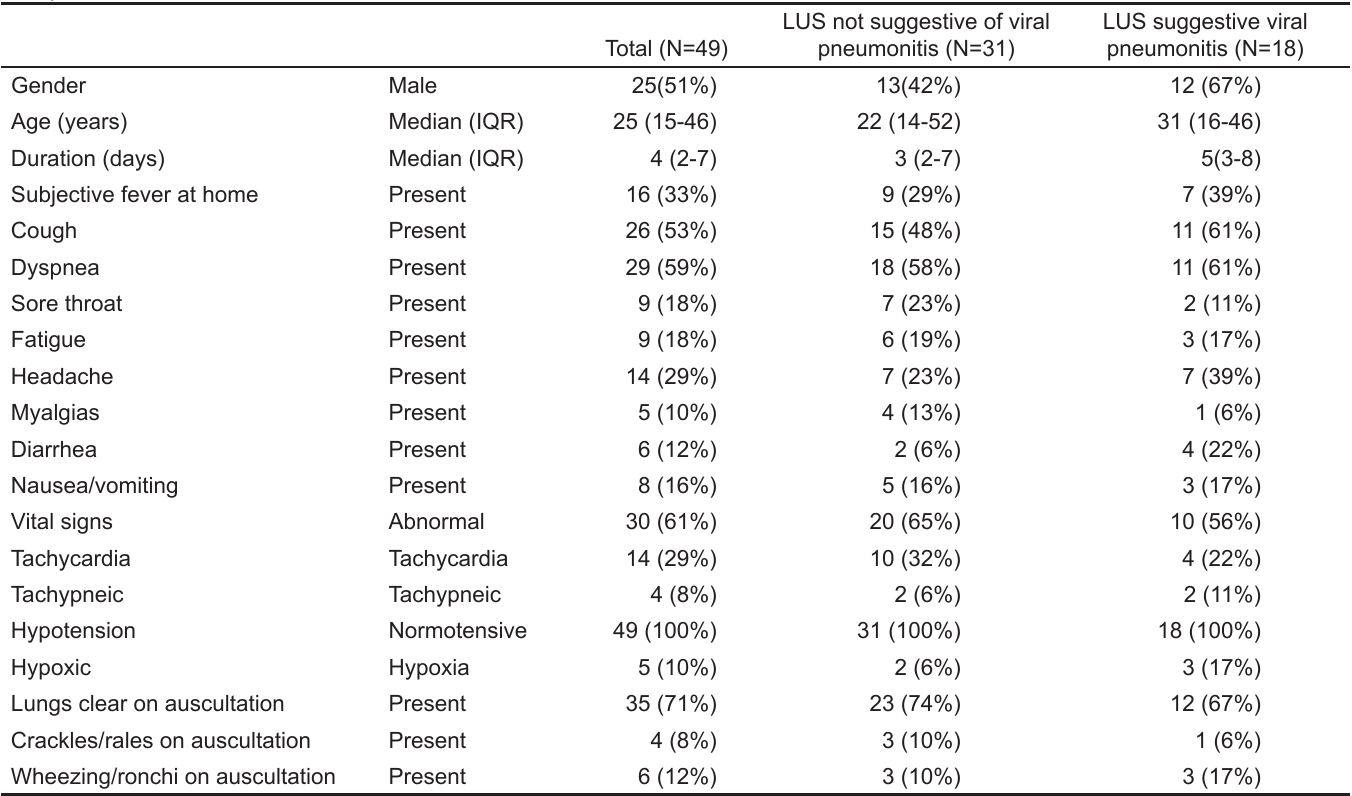
Table 1. Clinical characteristics of study patients overall, and the presence or absence of lung ultrasound findings consistent with viral pneumonitis.